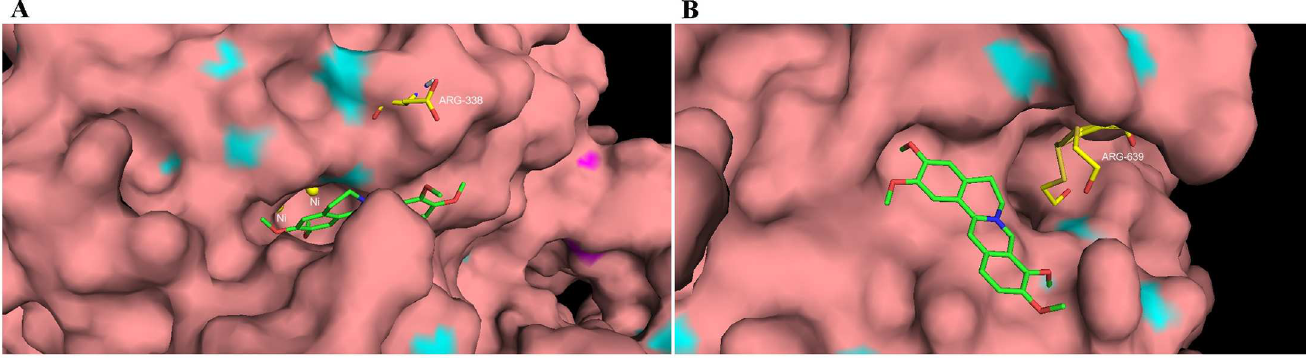
Fig 8. Surface representation of the active-siteflap of urease with Pal, shown at the entrance of the binding pocket. A: HPU, B: JPU. (colored by atom: carbon is green, nitrogenis blue, oxygen is red, hydrogenis gray and sulfur is